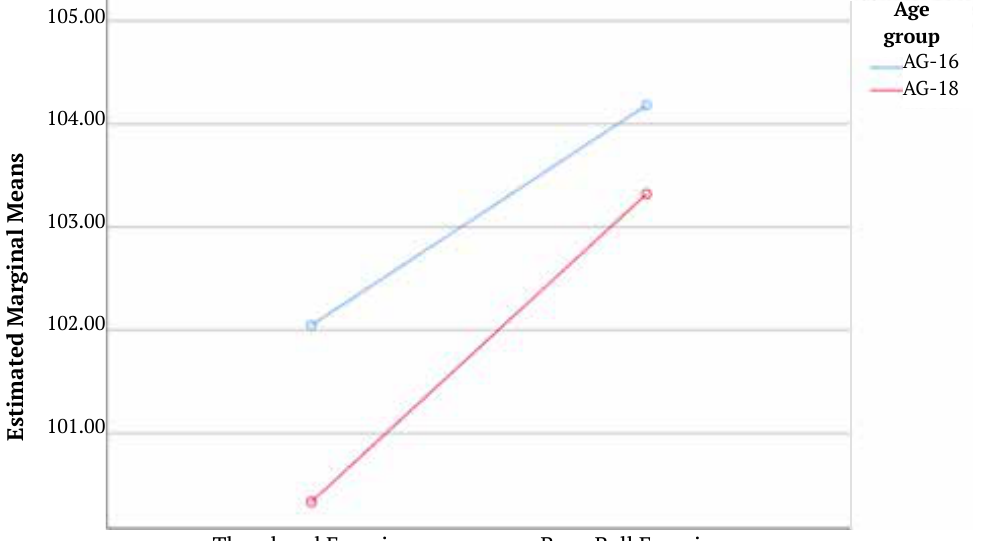
Figure 11. Raight